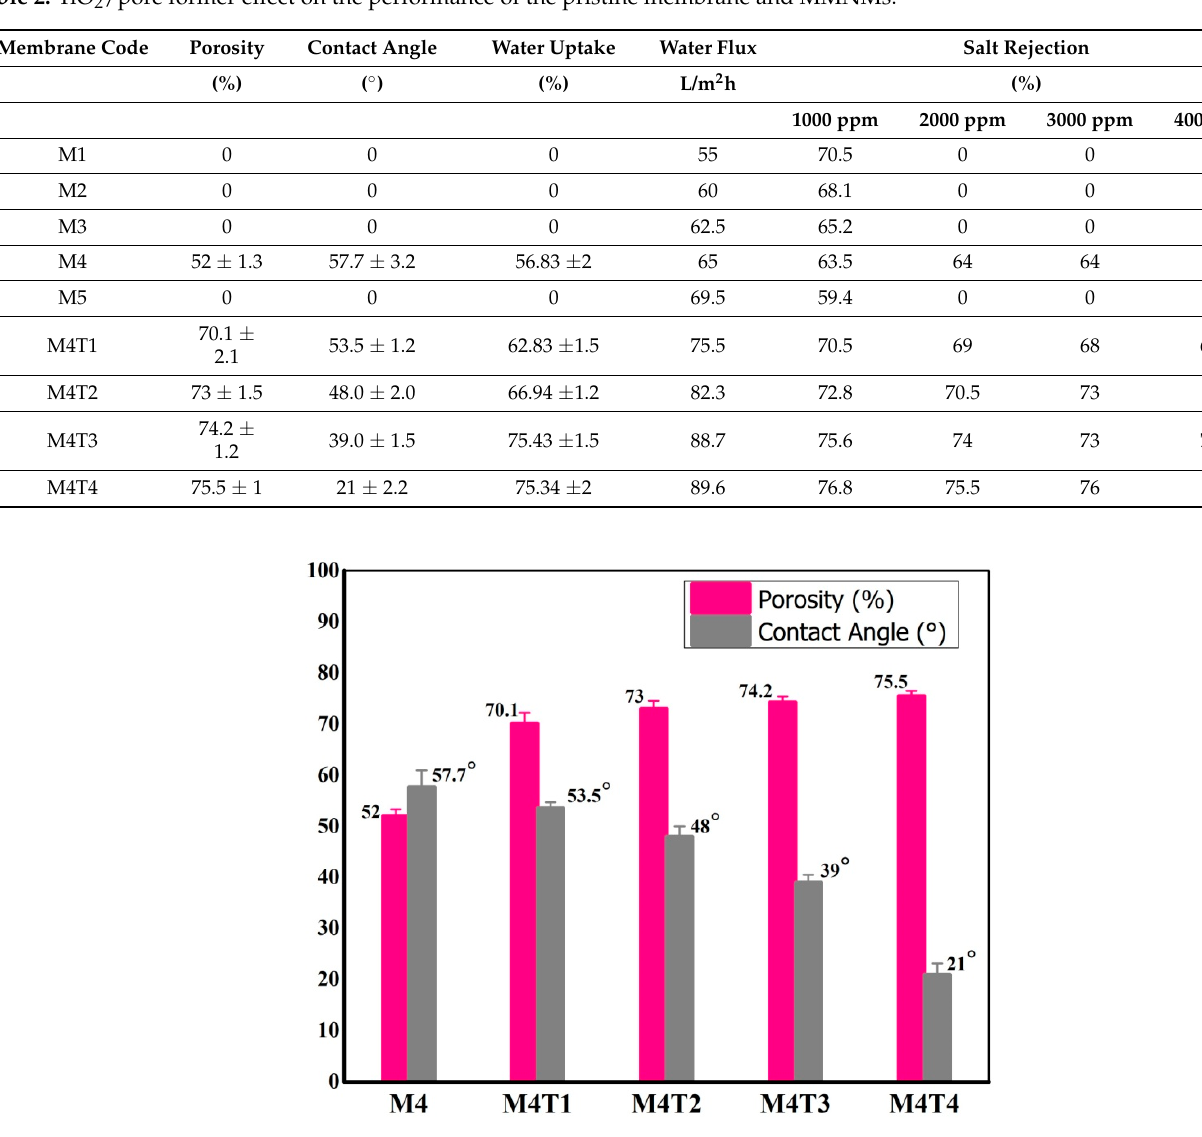
Figure 6. Static water contact angles: M4, M4T1, M4T2, M4T3, and M4T4. To determine the hydrophilicity, the contact angles of the membranes were meas- ured. This is an indirect evaluation and a major parameter. By using the sessile drop technique, the hydrophilicity of the M4–M4T4 composite membranes was calculated.